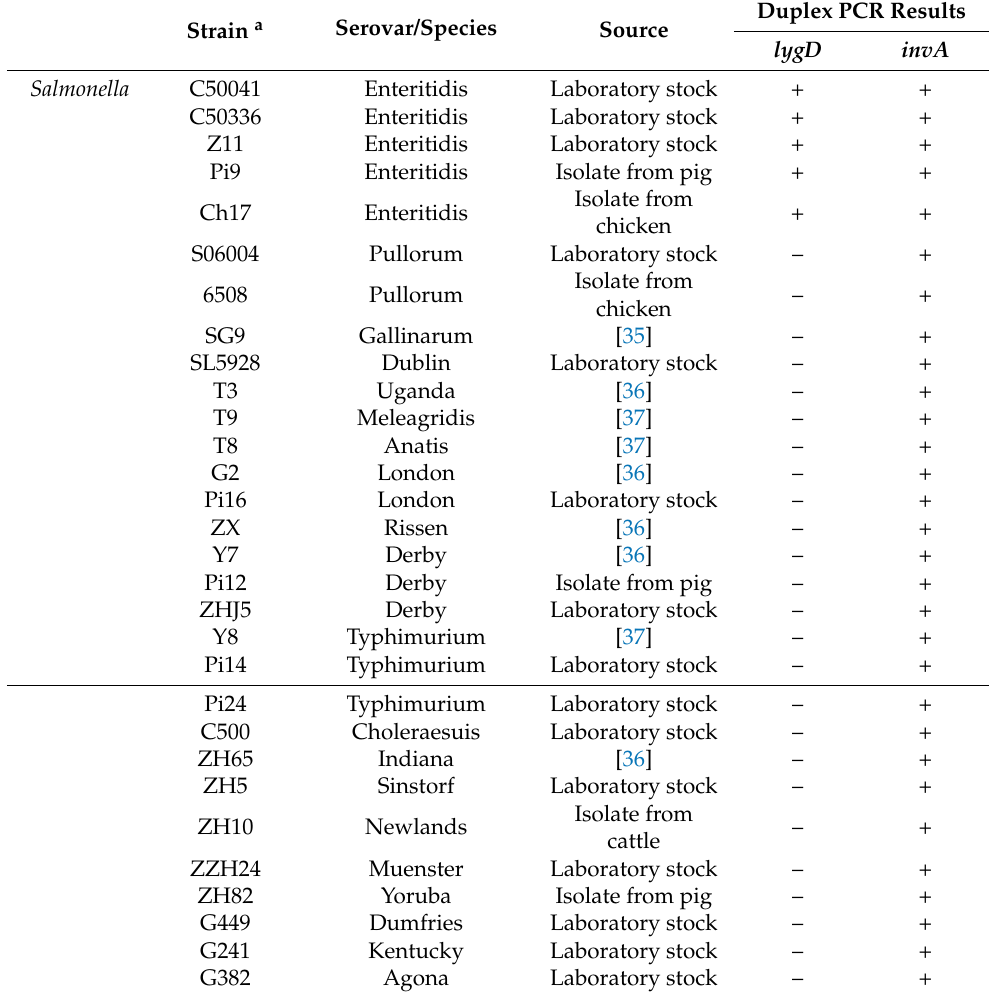
Table 1. Different Salmonella serovars and other non- Salmonella bacteria used to determine the specificity of the established real-time PCR